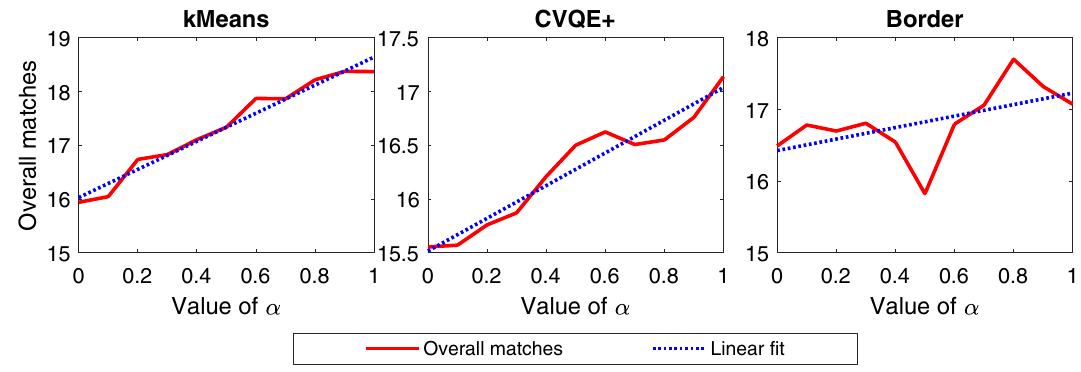
Fig. 14 The effect of 𝛼 on the smoothness of results on the dataset